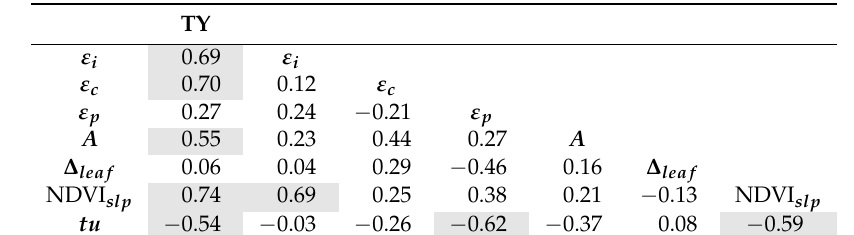
Table 3. Pearson correlation matrix among dry tuber yield per plant (TY), physiological ( A , ∆ leaf ), radiation-related ( ε i , ε c , ε p ), senescence delay (NDVI slp ) and tuberization precocity ( tu ) parameters. In gray: correlations > |0.5| between